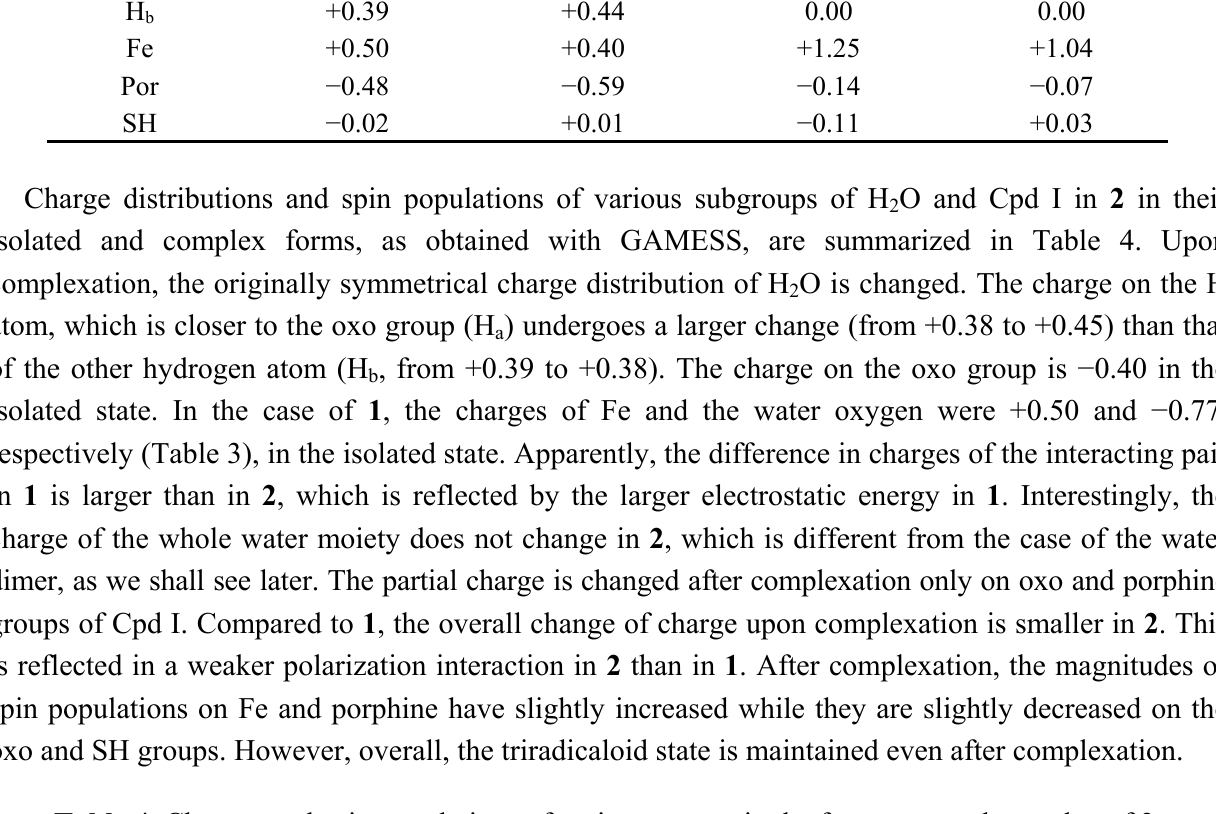
Table 4. Charges and spin populations of various groups in the fragments and complex of 2